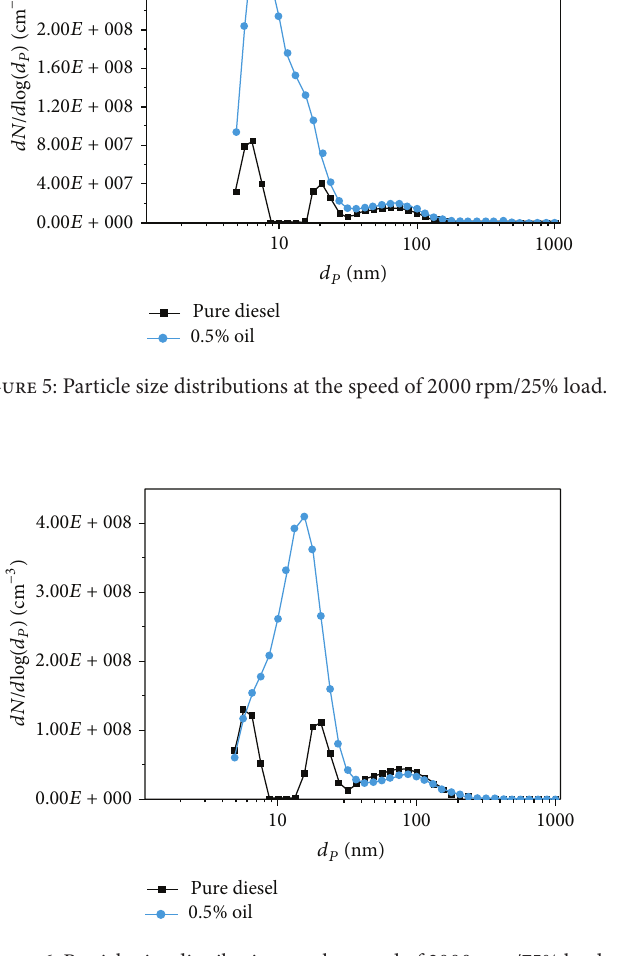
Figure 6: Particle size distributions at the speed of 2000 rpm/75% load.